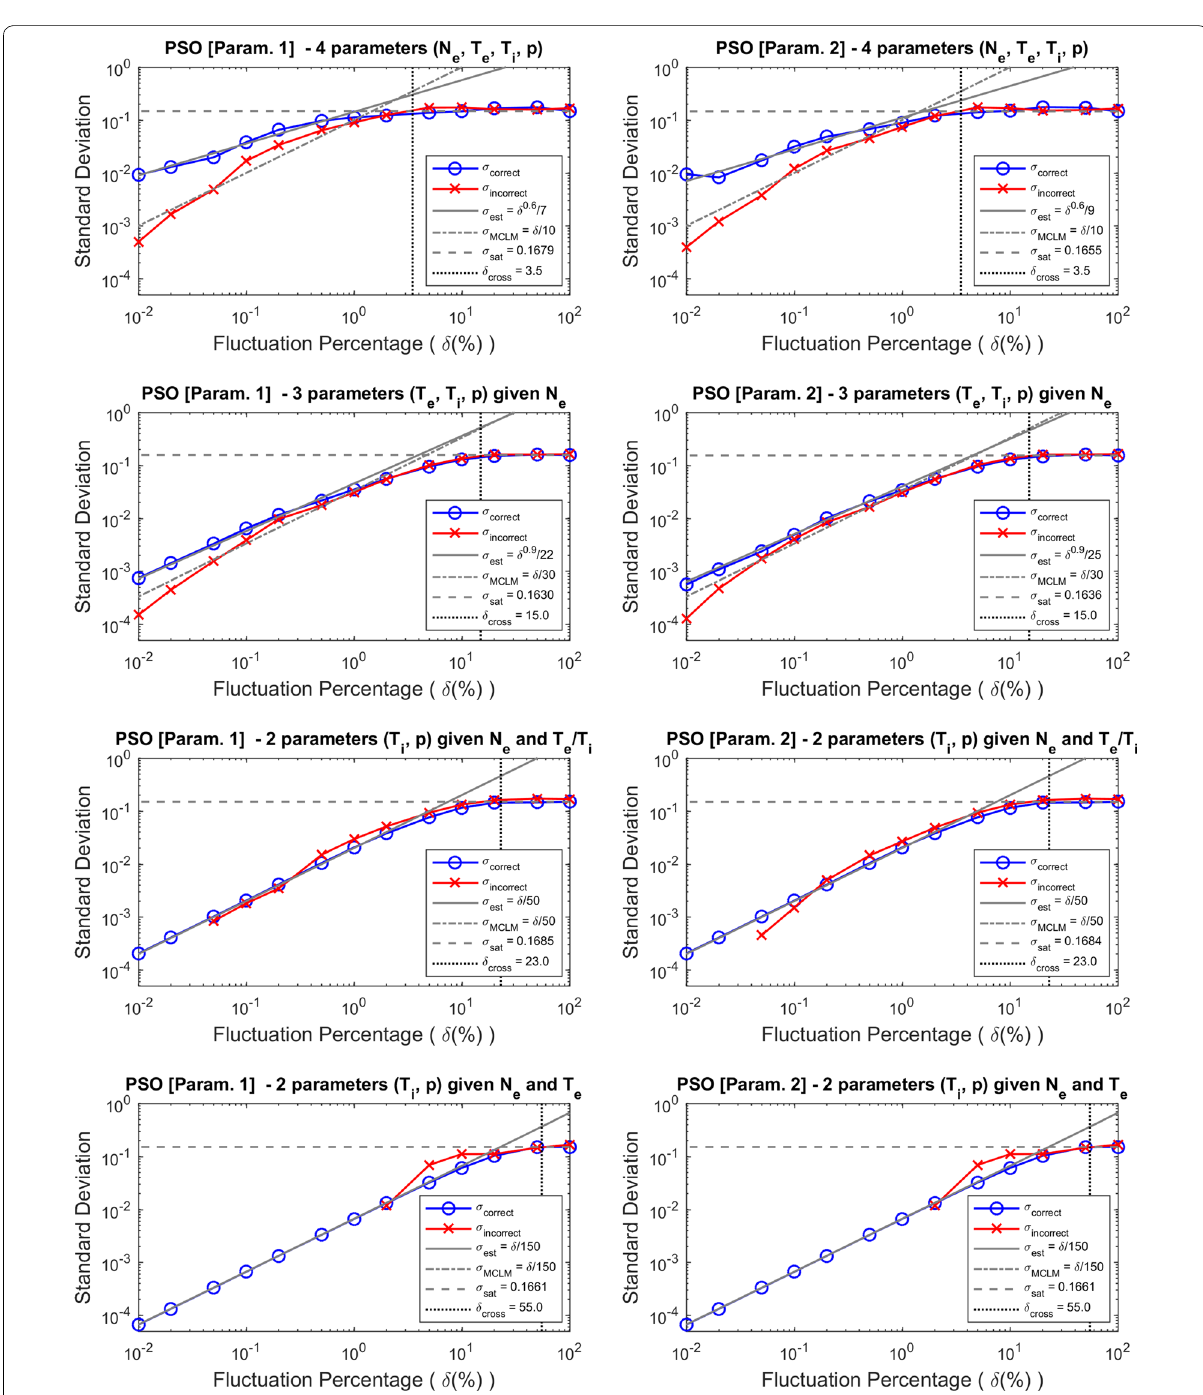
Fig. 7 Average standard deviation values (in logarithmical scale) of “correct” (blue) and “incorrect” (red) statistical distributions obtained by fitting simulations using the PSO algorithm with the configuration of parameters (left column) “Param. 1” used by Wu et al. (2015) and (right column) “Param. 2”. Simulations were done estimating different combinations of known a priori plasma parameters from the plasma line at different signal fluctuation percentages ( δ( % ) ). Vertical dotted line represents the estimated fluctuation value ( δ cross ) at which P correct = 50% . The maximum standard deviation value is represented with a horizontal dashed line ( σ sat ). The continuous black line represents the estimated regression of the standard deviation of “correct” solutions ( σ est ) before arriving to the saturation value. The dash‑dotted black line represents the estimated regression of the MCLM method ( σ MCLM